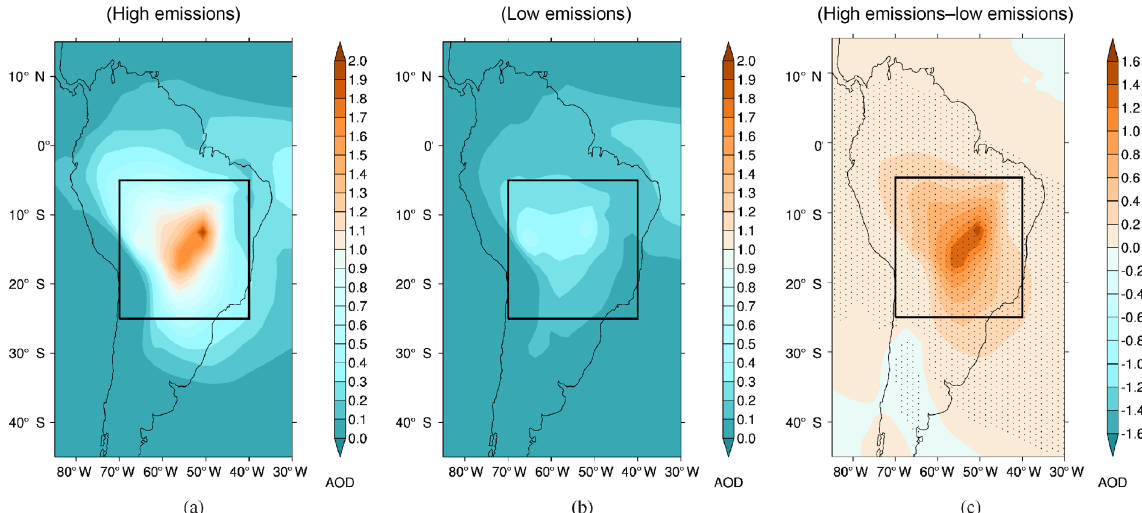
Figure 5. (a) The September mean biomass burning AOD at 0.44µm for the high emissions experiment. The outlined box contains the area used to calculate mean values in Table 1. (b) The September mean biomass burning AOD at 0.44µm for the low emissions experiment. (c) Plot of the difference in the September AOD between the high and low emissions experiment. Stippling represents 95% confidence limit.